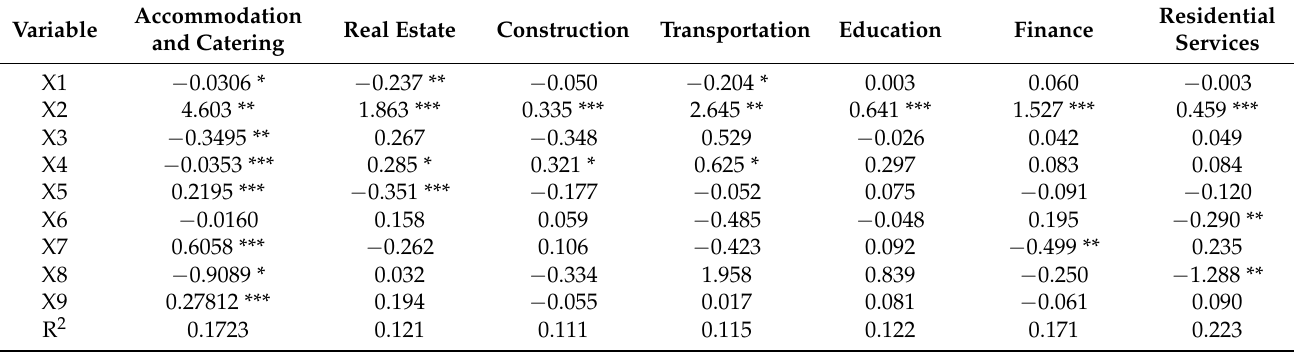
Table 5. Regression results of different types of industries’ location